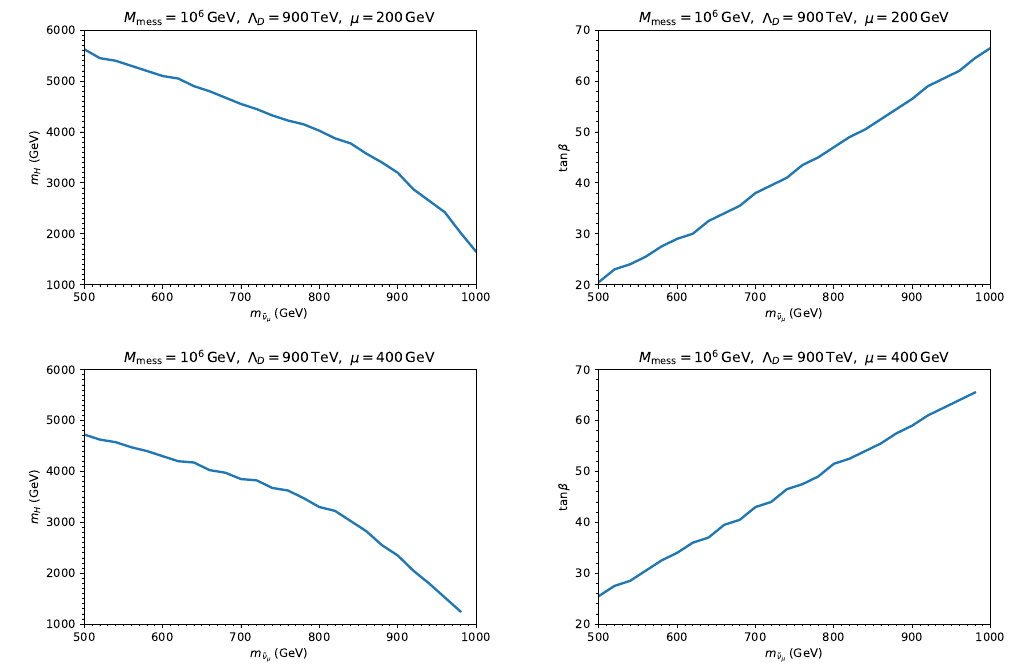
Figure 3 . The maximum value of m H (left) and corresponding tan β (right) as a function of m ˜ ν when we require 19 . 2 ≤ ( a